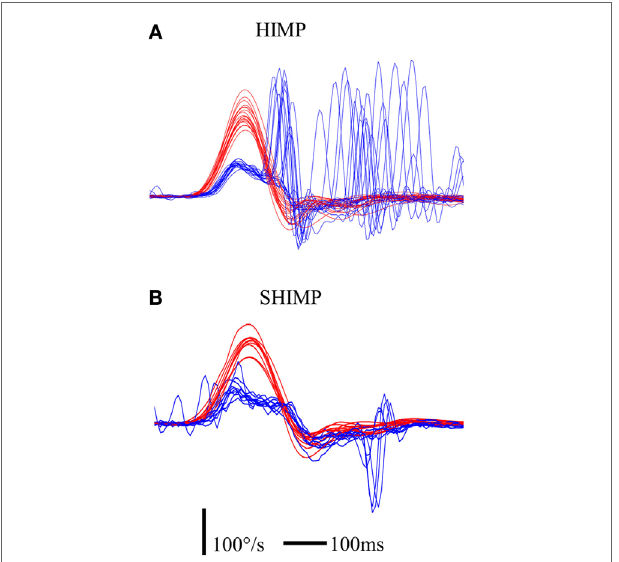
FigUre 8 | illustration of saccadic pattern in hiMP (a) and shiMP (B) paradigms in a UVl patient suffering from Meniere’s disease and treated by intratympanic gentamycin injections at early stage (3 days after injection) . The UVL patient was able to make covert compensatory saccades in HIMPs, but not anti-compensatory saccades in SHIMPs. Notice that the HIMP HVOR gain of this patient was 0.41. Red curve: head velocity; blue curve: eye velocity; blue circle: peak saccade velocity; vertical bar: 100°/s; horizontal bar: 100